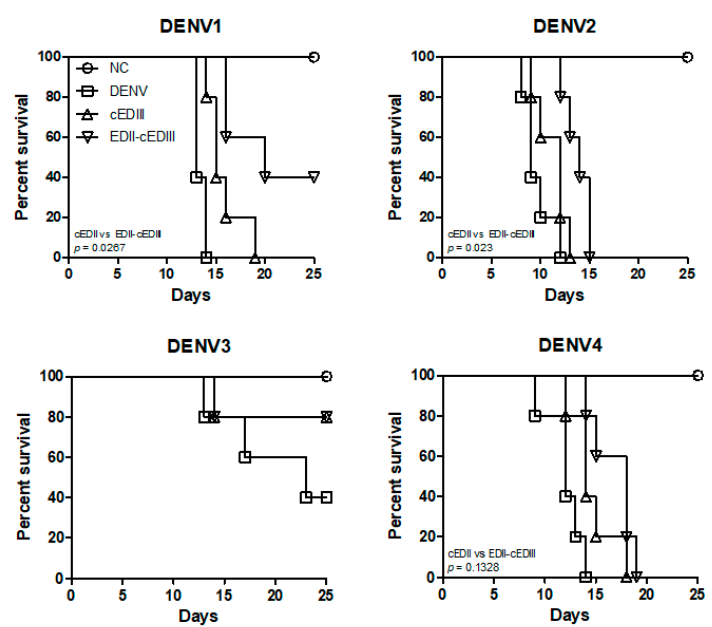
Figure 4. Purified Ab increases the survival of DENV-infected AG129 mice. Survival of AG129 mice after intraperitoneal administration of DENV in the presence of purified Ab or PBS was determined. Abs were intraperitoneally injected on day − 1 and day 0 together with DENV. p -values between two groups were calculated by log-rank test, n = 5 mice per group. Squares, DENV; triangles, anti-cEDIII Ab treatment group; inverted triangles, anti-EDII-cEDIII Ab treatment group. A representative result from three independent experiments is shown.